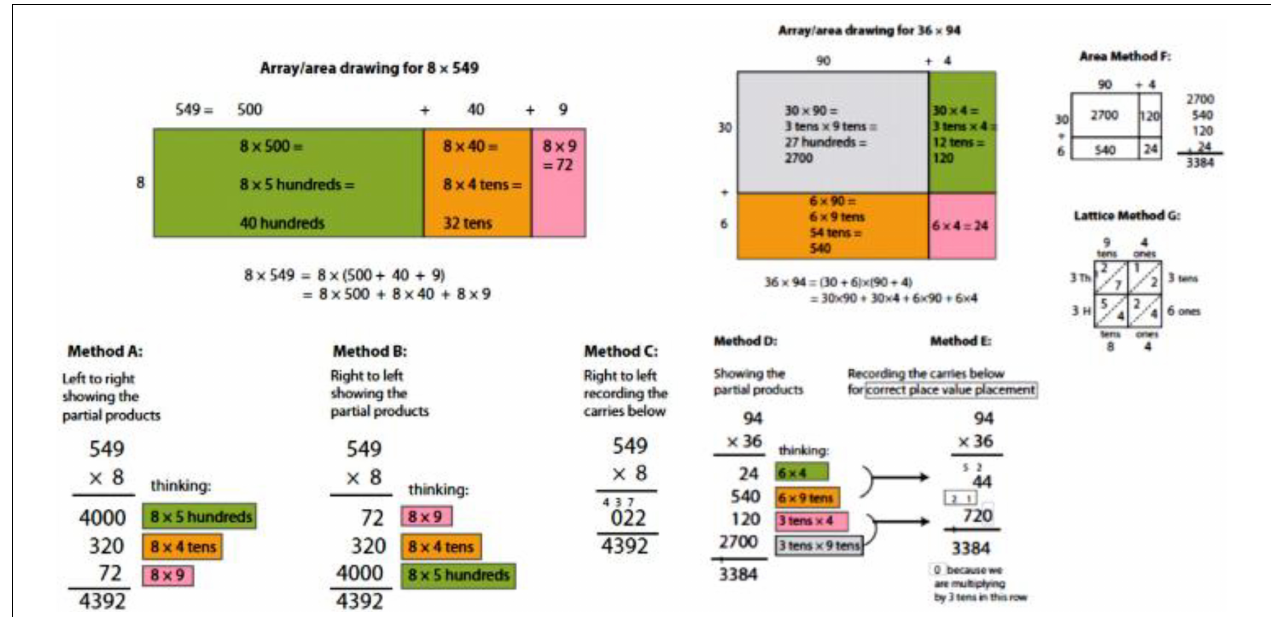
FIGURE 5 | Alternative multiplication and division algorithms used in the United States’s education system. Source: Fuson and Beckmann (2013, p.